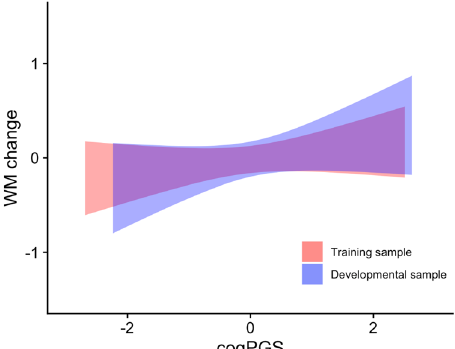
Fig. 2 Regression of cogPGS on the change in WM for the training sample (red) and the developmental sample (blue). The WM change variable is the subtracted baseline WM from the follow-up WM in each sample and then separately standardized (mean of zero and standard deviation of 1). Values of zero represent the mean change in each sample. Values of cogPGS are also standardized to have a mean of zero and a standard deviation of one. Shades represent 95% con fi dence